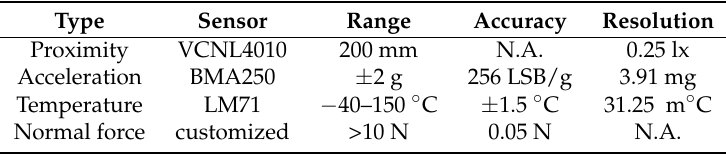
Figure 2. ( a ) The robotic arm equipped with a multi-modal artificial skin; ( b ) The multi modal artificial skin. Table 1. Technical information of sensors in the artificial skin